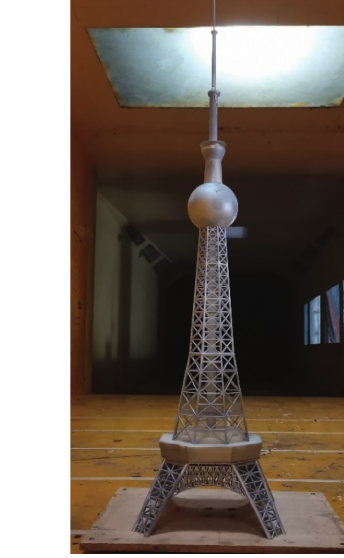
Figure 1: Foshan TV Tower. Table 1: Parameters of the different sections of the wind tunnel test model.